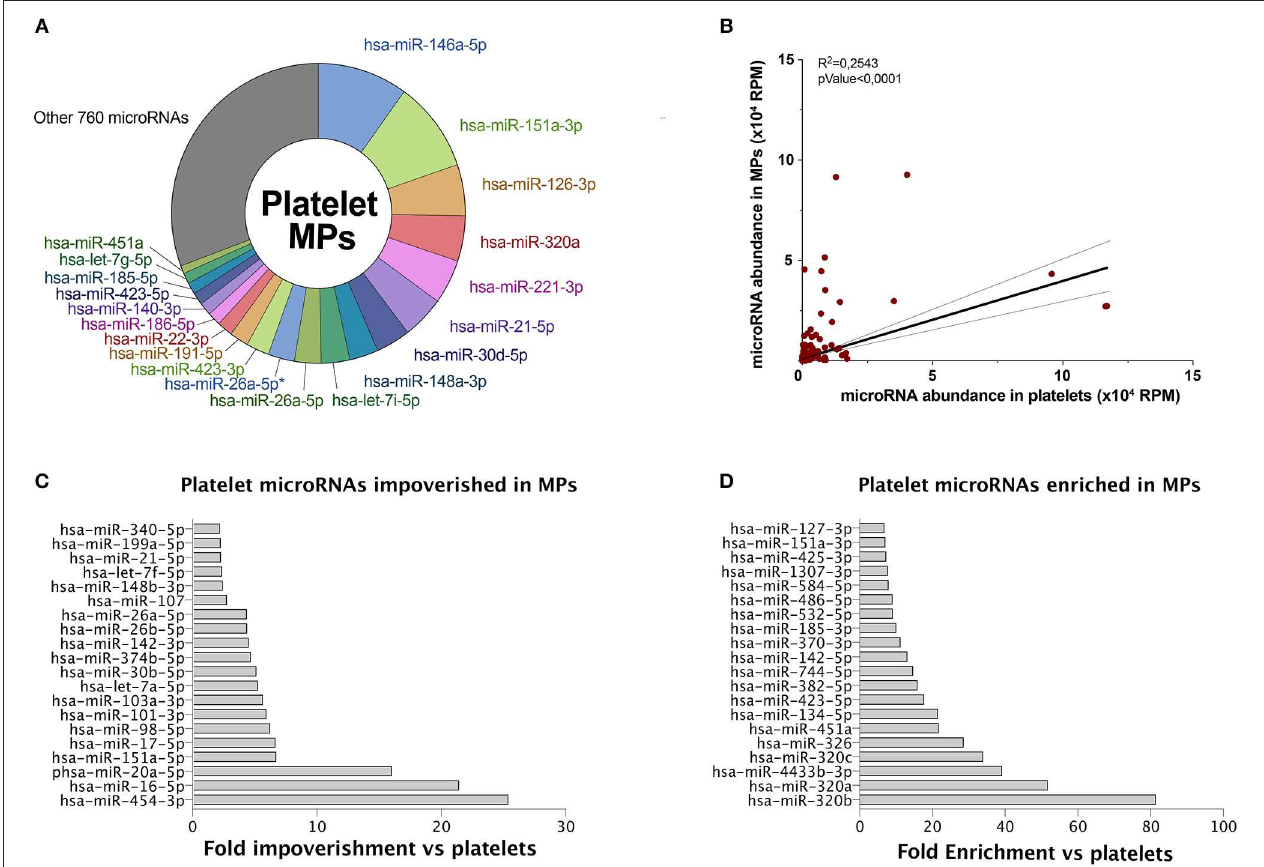
FIGURE 2 | Platelet microRNAs are differentially partitioned into MPs. MPs were isolated from control PCs. Total RNA was extracted and pooled from six donors prior to small RNA-Seq analysis, as done for platelets in Figure 1 . (A) Circular diagram representing the 20 most abundant microRNAs in platelet MPs, along with other microRNAs and their relative proportion. *IsomiR sequence. (B) Pearson’s correlation of microRNA abundance in platelet MPs vs. platelets. (C) The 20 most abundant microRNAs, above 1,000 RPM, specifically impoverished in platelet MPs vs. platelets. (D) The 20 most abundant microRNAs, above 1,000 RPM, specifically enriched in platelet MPs vs. platelets. Hsa, Homo sapiens ; MPs, microparticles; PCs, platelet concentrates; RPM, reads per